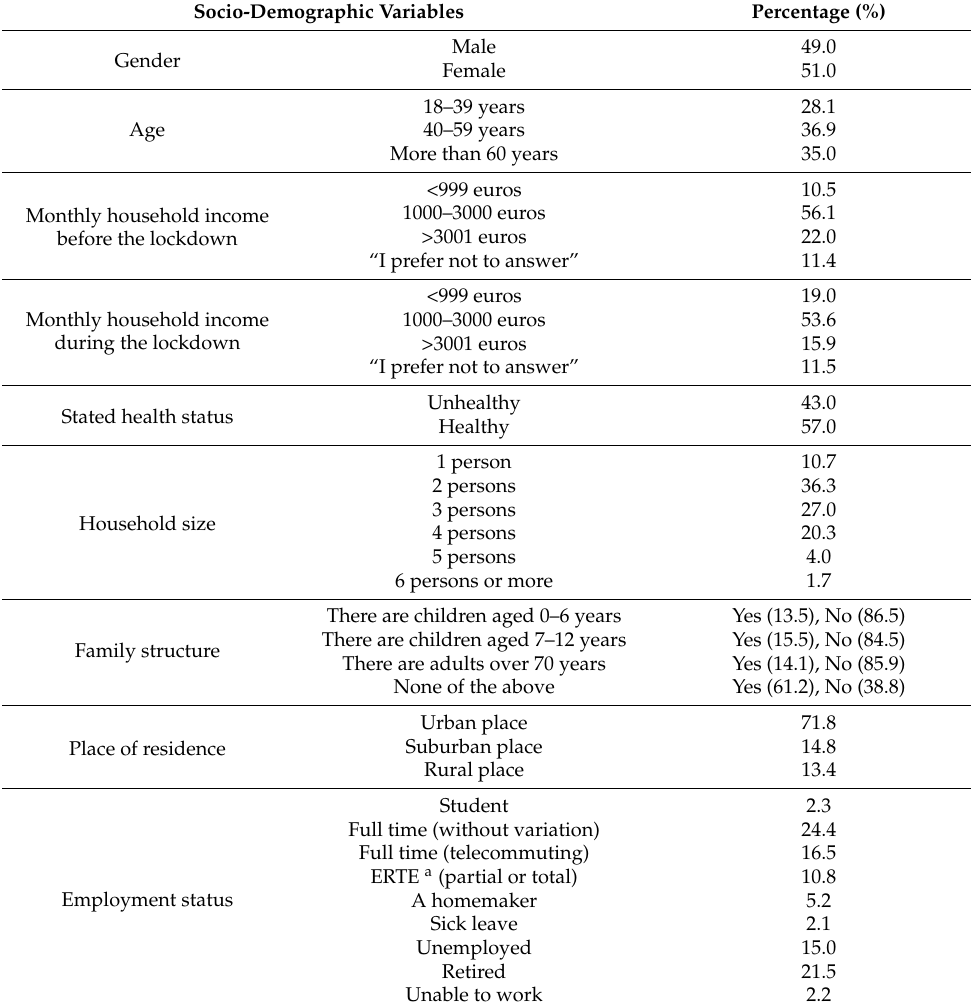
Table 1. Socio-demographic variables in this research ( n =